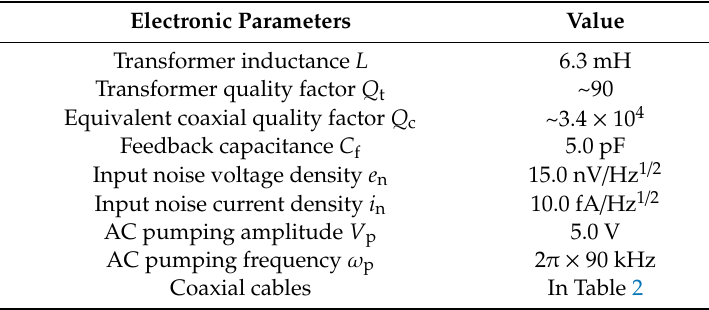
Table 1. Main typical parameters of the capacitive transducer.